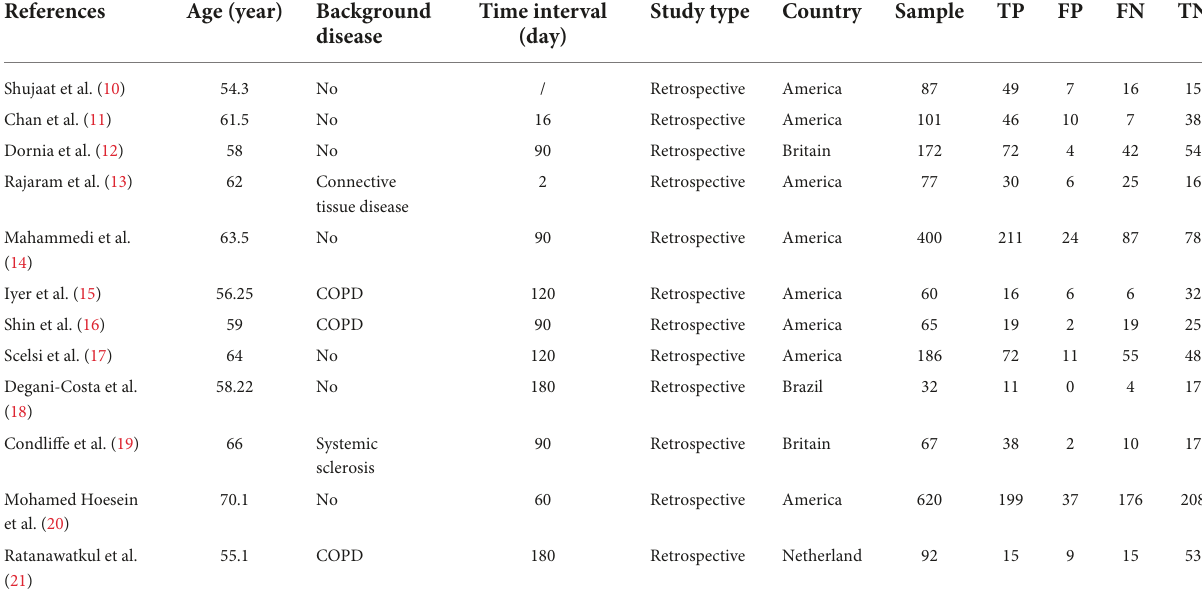
TABLE 1 Basic characteristics of the included